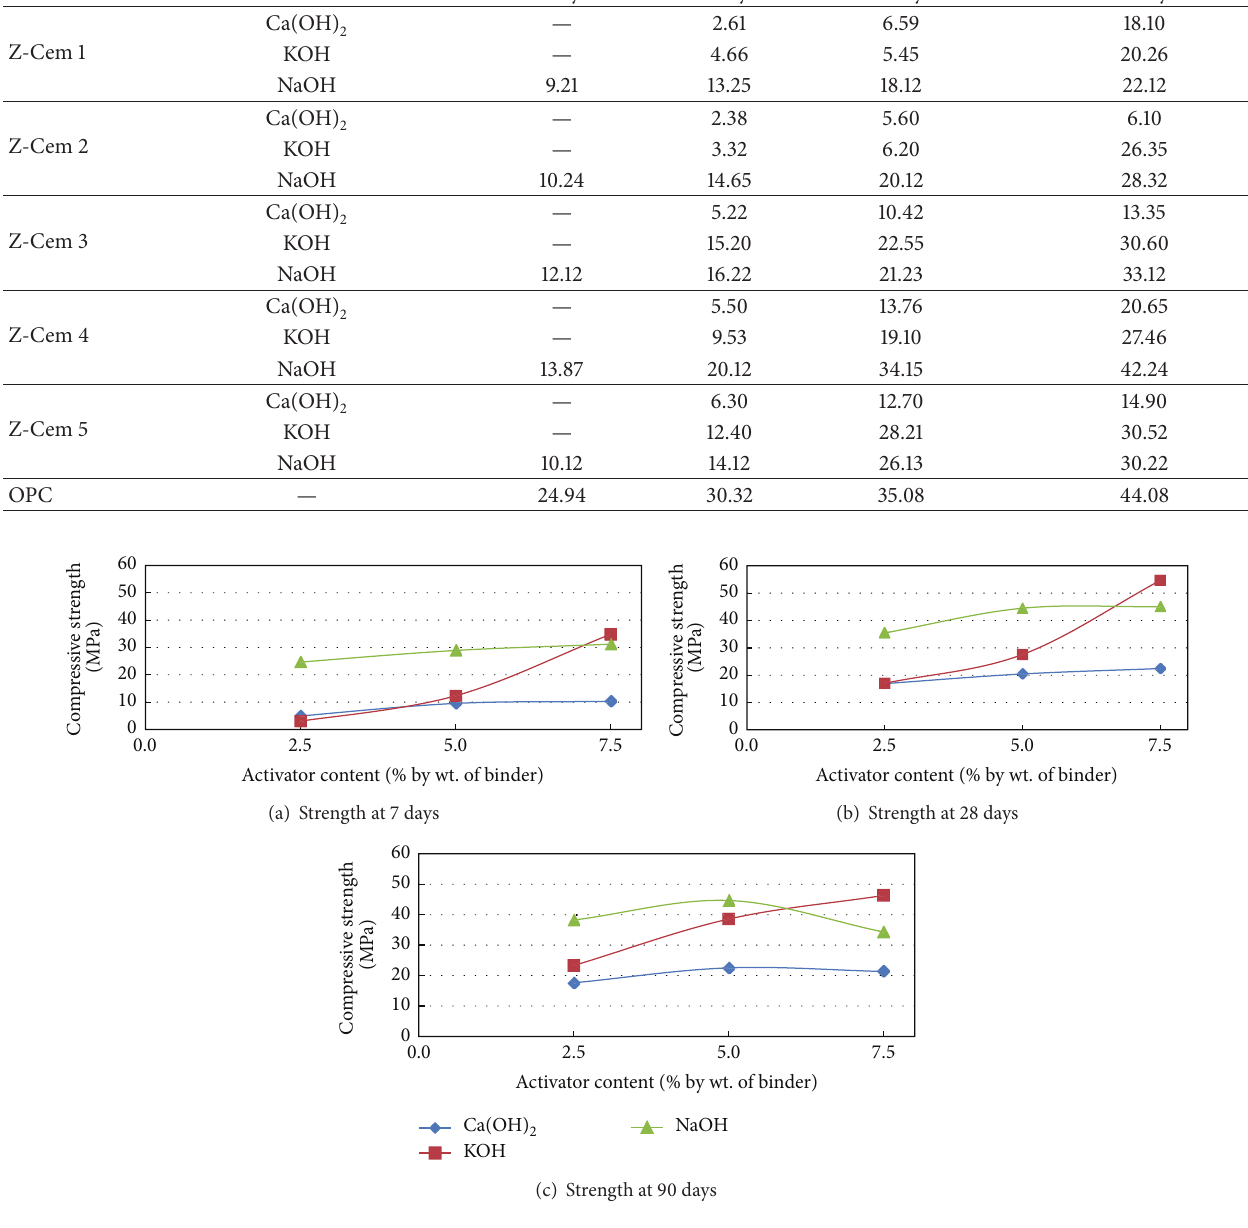
Figure 3: Compressive strength of mortar (Z-Cem 4) as influenced by amount of